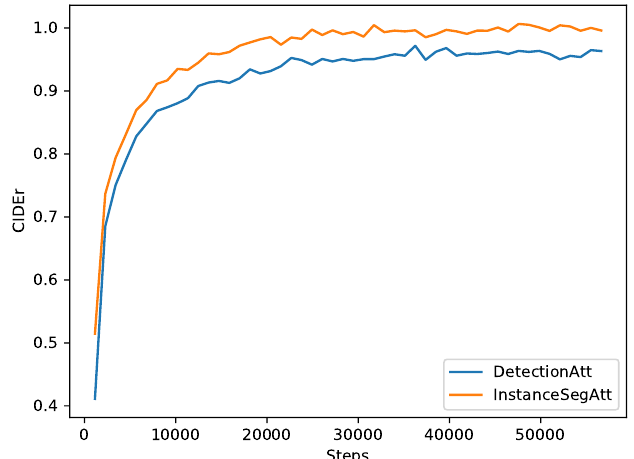
Figure 6. Comparison of CIDEr scores on the validation set for InstanceSegAtt and DetectionAtt during 50 epochs’